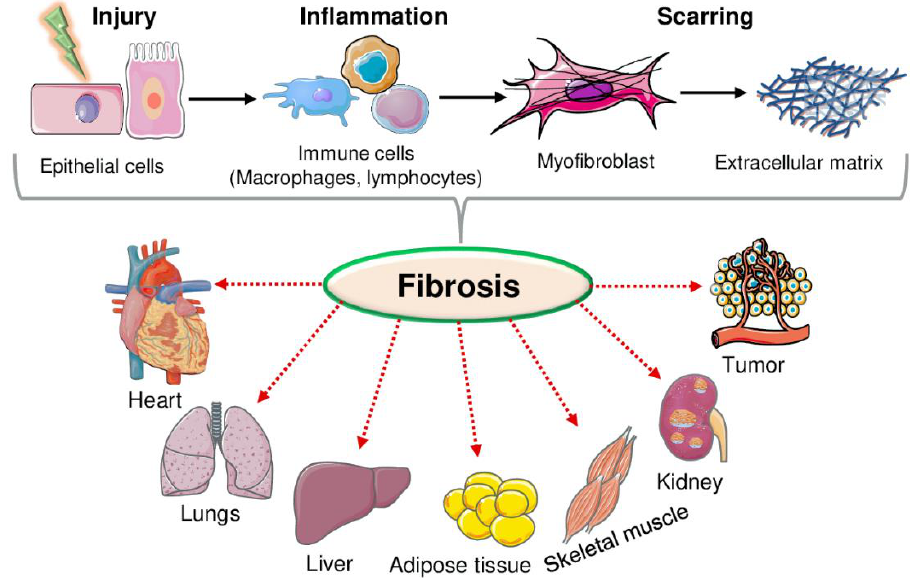
Figure 1. After injury, damaged cells recruit inflammatory cells (e.g., monocytes, neutrophils, and other immune cells), which promote fibroblasts differentiation into ECM-producing myofibroblasts, leading to fibrosis in various tissues.